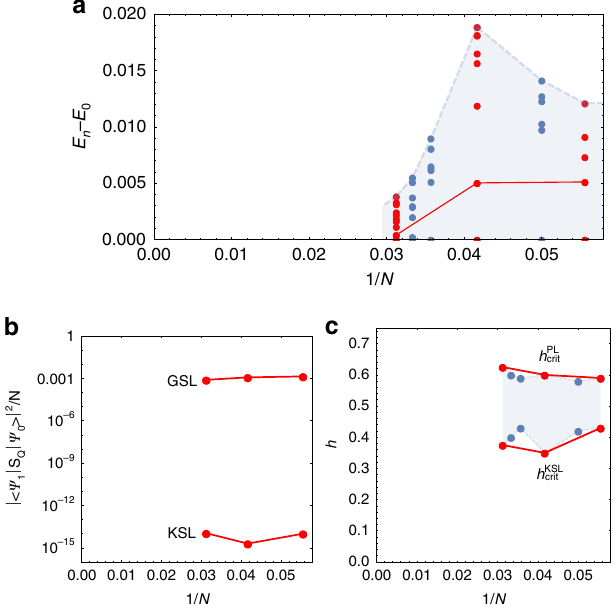
Fig. 8 Finite-size scaling. Shown, for a range of system sizes, are a the energy gaps between the ground state and the lowest lying state from each momentum sector for a point midway in the GSL phase, b the critical fi elds associated with the transition out of the KSL and into the PL phase, and c the spin spectral weight associated with the fi rst excited state in the KSL and GSL phases. All data is taken along the cut corresponding to the upper of the two dashed lines (red) in Fig.